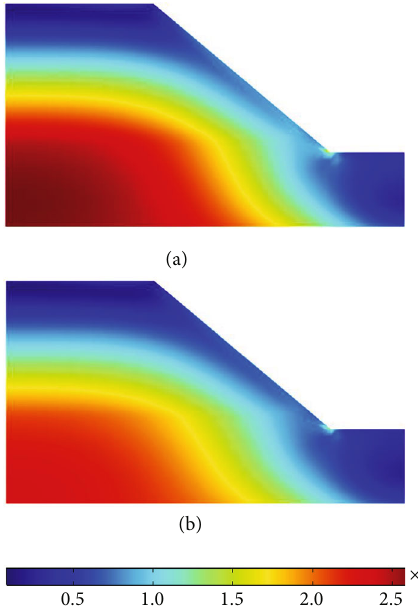
Figure 8: Comparison of e ff ective stress contours in two cases (the 5 th day of rainfall, unit: Pa). (a) E ff ective stress in the case considering the coupling e ff ect of pore water pressure and pore water gravity. (b) E ff ective stress in the case considering only the e ff ect of pore water